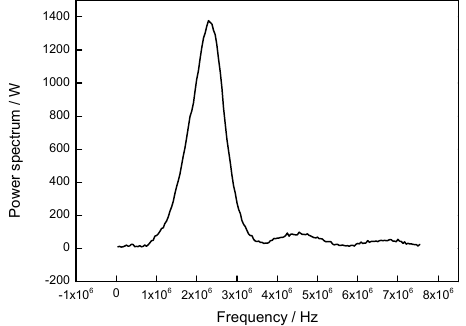
Figure 4. The frequency domain of L cr wave.